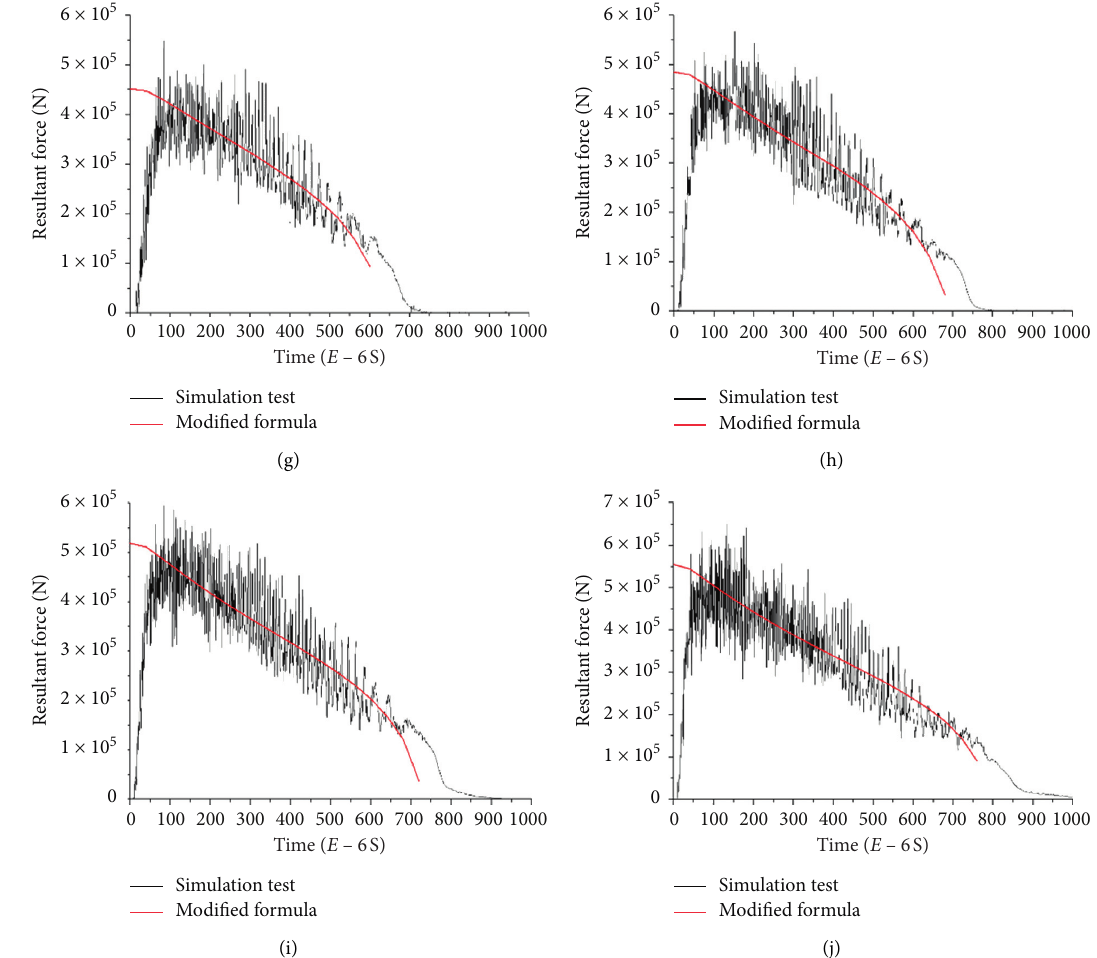
Figure 12: Comparison between simulation and modified formula of stone penetration. (a) 100 MPa. (b) 120 MPa. (c) 140 MPa. (d) 160 MPa. (e) 180 MPa. (f) 600 m/s. (g) 700 m/s. (h) 800 m/s. (i) 900 m/s. (j) 1000